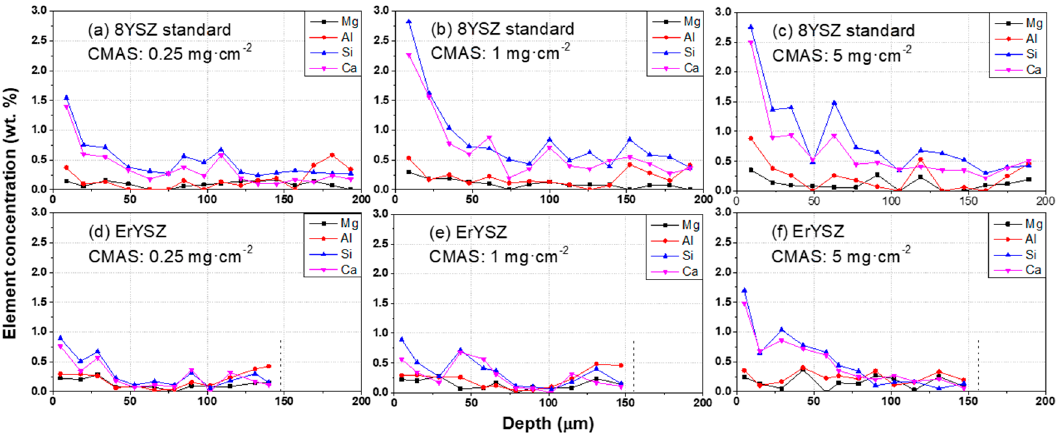
Figure 5. Energy-dispersive spectrometry (EDS) elemental analysis of the CMAS compounds present in the cross-sections of ( a – c ) standard 8YSZ and ( d – f ) co-stabilised ErYSZ after annealing at 1250 °C for 1h with ( a , d ) 0.25 mg·cm − 2 ( b , e ) 1 mg·cm − 2 and ( c , f ) 5 mg·cm − 2 of CMAS deposits.